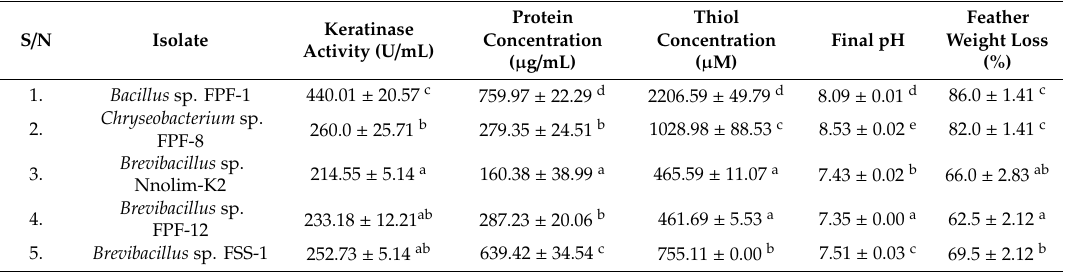
Table 2. Keratinolytic activities of the bacterial fermentation from chicken feathers.